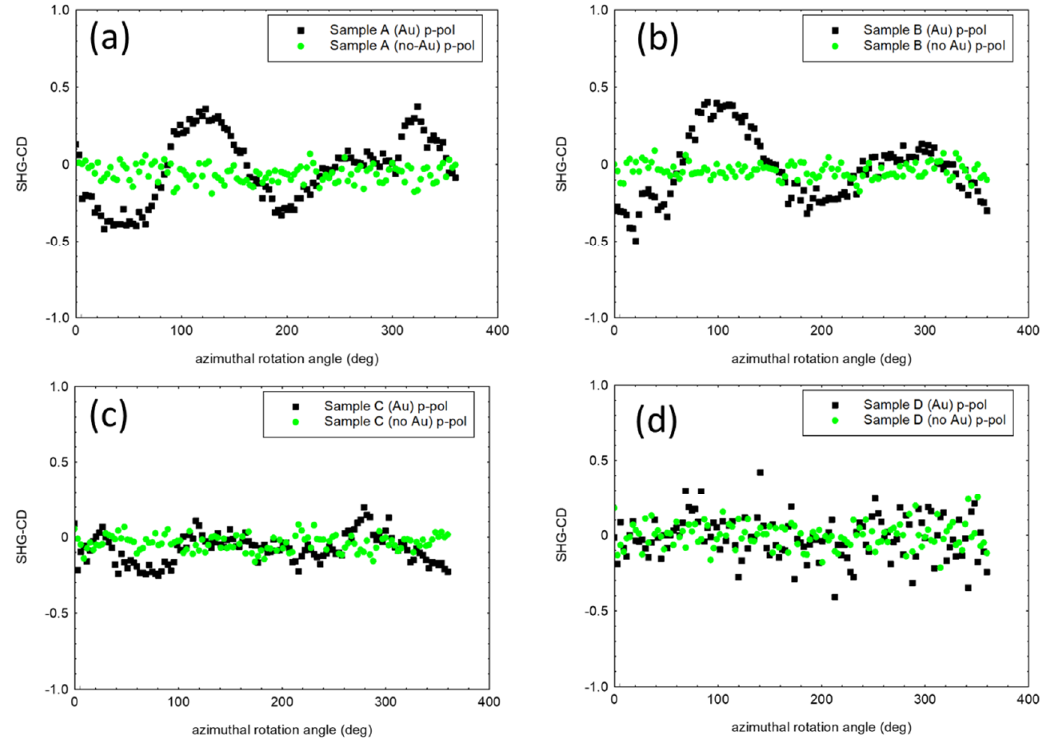
Figure 6. SHG-CD signal of the Samples without Au and with Au. SHC-CD for: ( a ) Sample A; ( b ) Sample B; ( c ) Sample C; ( d ) Sample D. In the measurements the azimuthal rotation angle is relative.